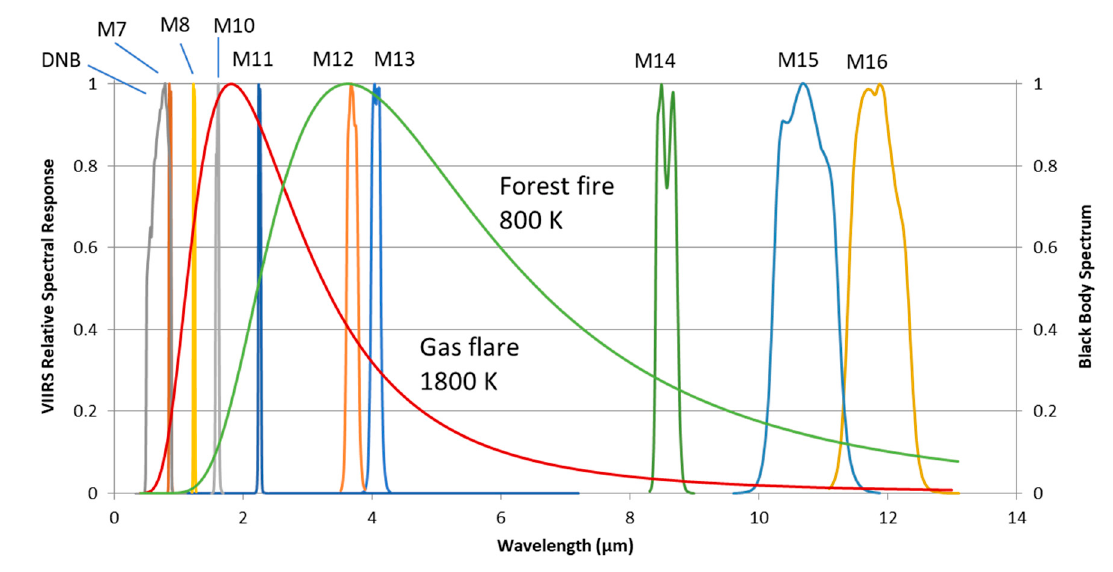
Figure 1. Relative spectral responses of the VIIRS visible (DNB) and infrared (M7–M16) channels available in the satellite night-time observation mode. Spectral bands are overplayed with the Planck blackbody radiance for typical temperatures 1800 K (gas flare) and 800 K (forest fire).